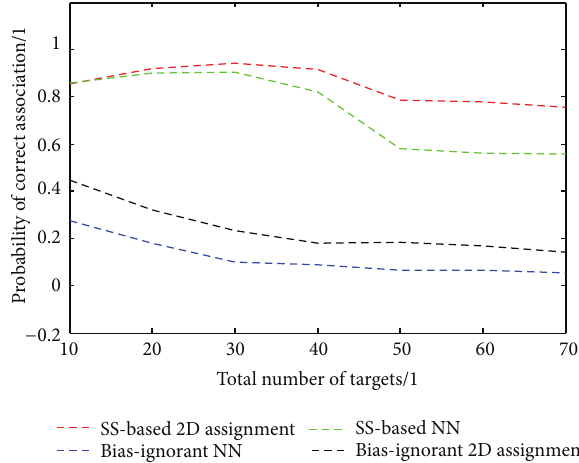
Figure 7: Average probability of correct association via different detection probabilities.